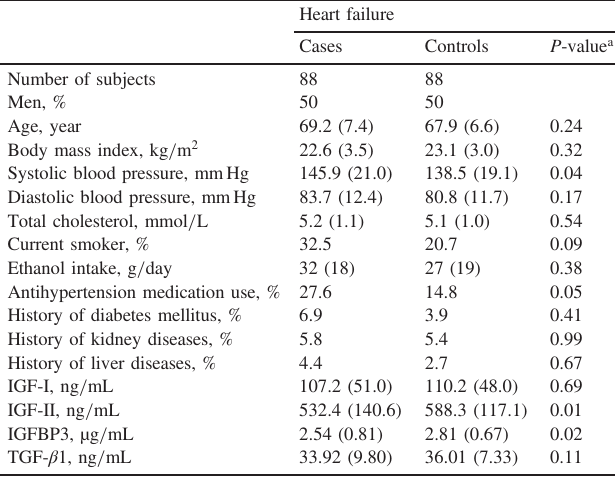
Table 1. Age- and sex-adjusted mean values (standard devia- tion) and proportions of cardiovascular risk character-